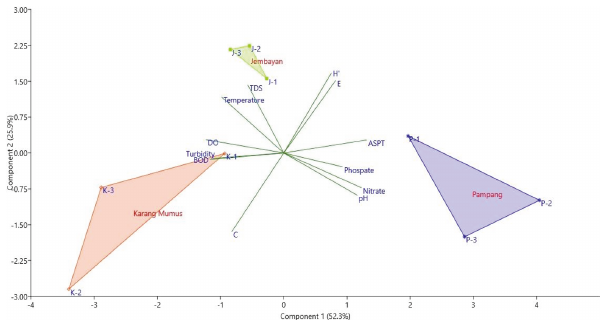
Figure 6: Diagram of sampling sites by Principal Component Analysis(PCA),basedonthebioticmeasuresandphysical-chemical variables in East Kalimantan of Indonesia in June